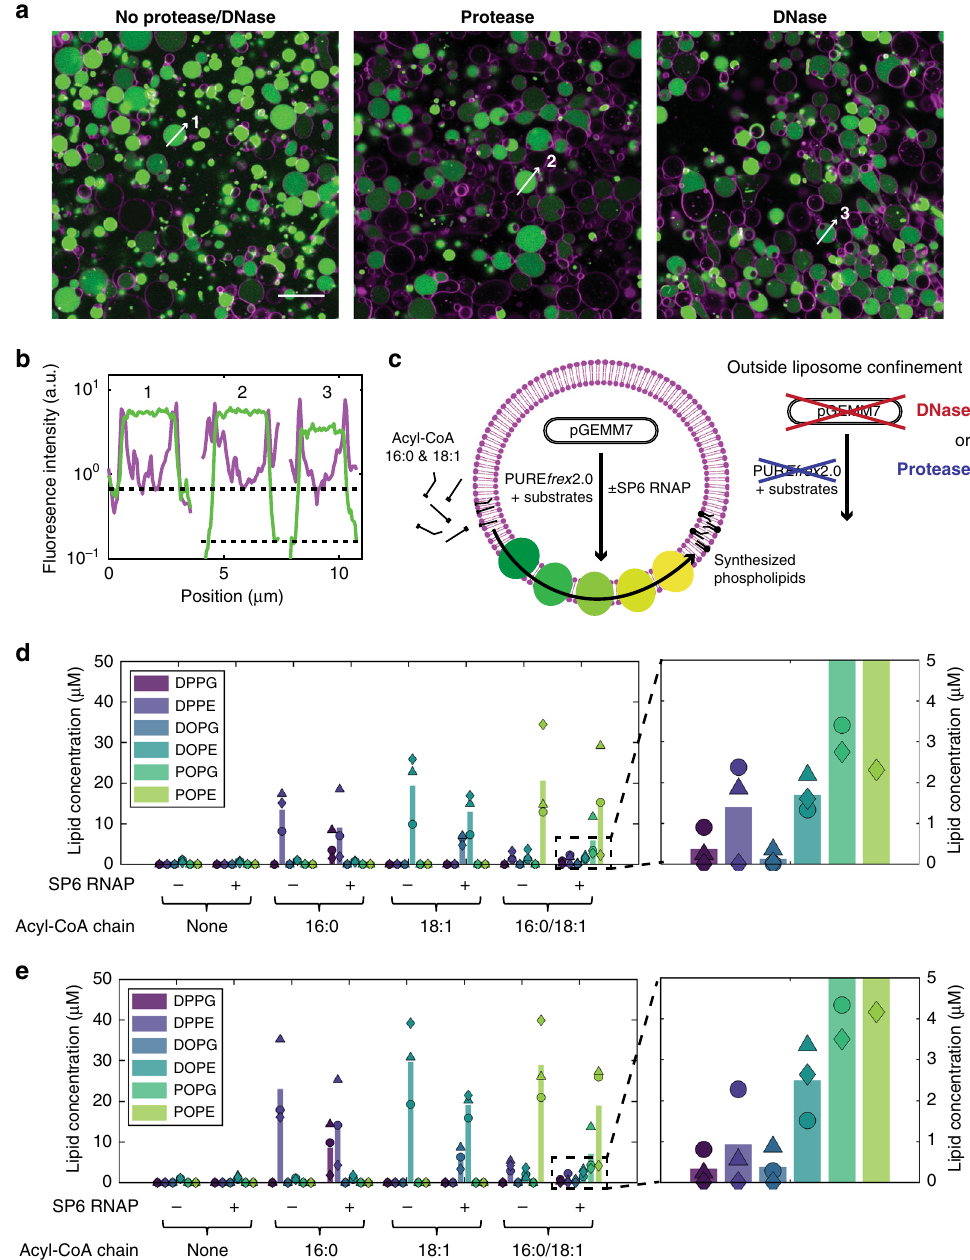
Fig. 3 DNA-programmed phospholipid synthesis inside giant vesicles. a Fluorescence images of liposomes (membrane in magenta) encapsulating PURE frex 2.0, 5 mM β -mercaptoethanol and 7 nM DNA encoding for the YFP (in green). Gene expression was con fi ned inside liposomes by external addition of either proteinase K (middle) or DNase I (right), or was allowed to also occur outside liposomes (left). Liposomes were diluted (2 μ L in 7.5 μ L total) to reduce their surface density and aid visualisation. Scale bar indicates 20 μ m; all pictures have the same size and were acquired with identical imaging settings. This experiment was repeated twice and similar results were obtained. b Fluorescence intensity line pro fi les for the liposomes indicated in ( a ). Colour coding is the same as in ( a ). Dotted black lines indicate the background YFP level without (top) and with (bottom) protease/DNase. c Schematic representation of in-liposome gene expression coupled to phospholipid synthesis. d , e Concentration of synthesized phospholipids inside ( d ) or both inside and outside liposomes ( e ), as determined by LC-MS. Compartmentalisation of gene expression was ensured by addition of proteinase K in the external environment. Different combinations of acyl-CoA precursors and SP6 RNAP were used. Concentrations of oleoyl-CoA and palmitoyl-CoA were 100 μ M when added separately, and 50 μ M each when added together. Symbols indicate measurements from three independent experiments and the bars represent mean values. A small amount of DOPE was measured in samples where no acyl-CoA was supplied. This represents the naturally occurring heavy-isotope fraction of the DOPE contained in the initial liposome membrane. The right panels are blow-up graphs of the indicated area in the left panels. Source data are available for ( d , e